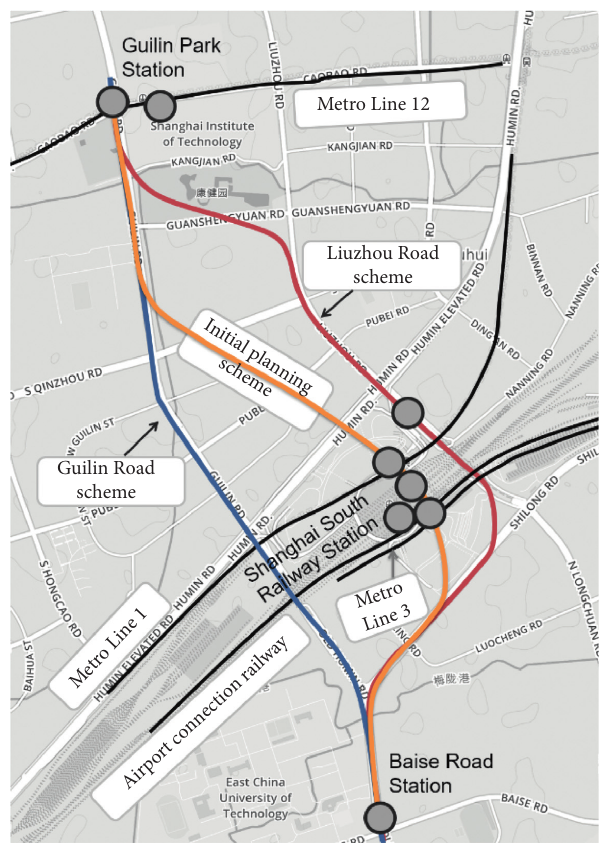
Figure 2: Plan view of the potential route